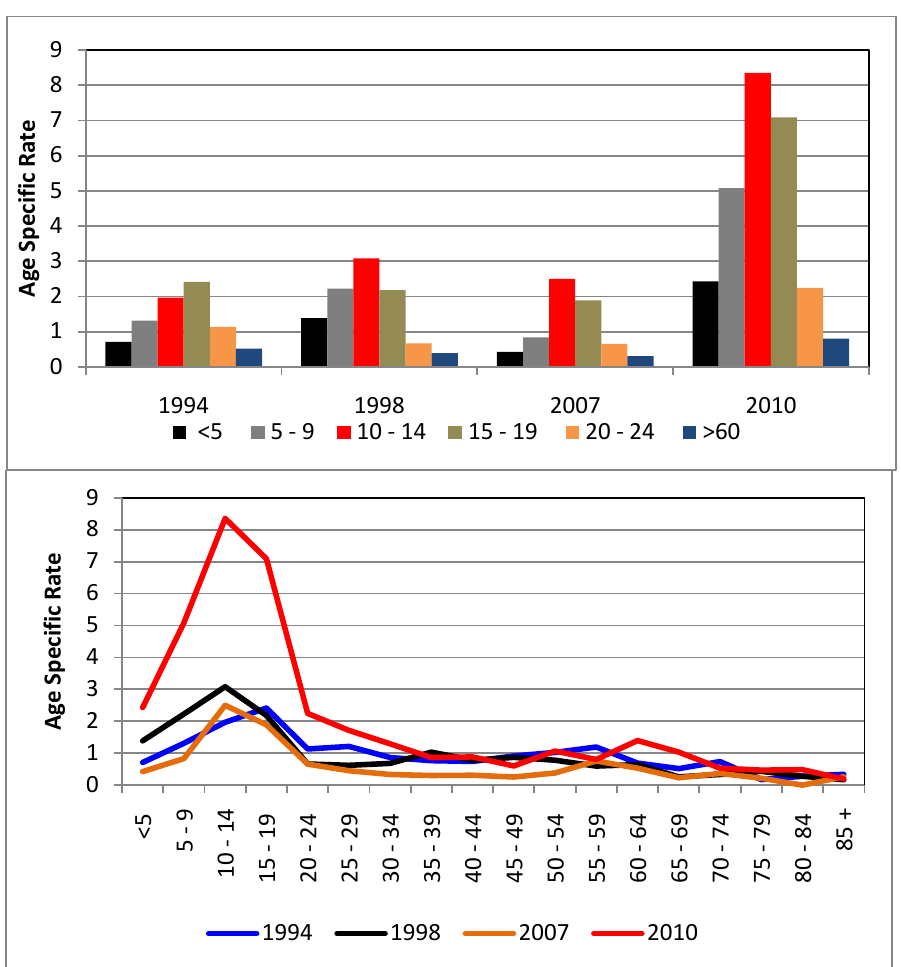
Figure 7. Comparison of age-specific dengue incidence rates per 1000 inhabitants in epidemic years (1994, 1998, 2007, and 2010) in San Juan. Upper Panel: Age-specific dengue incidence rates (age groups <24 years old and >60 years old). Lower Panel: Age-specific dengue incidence rates (all age